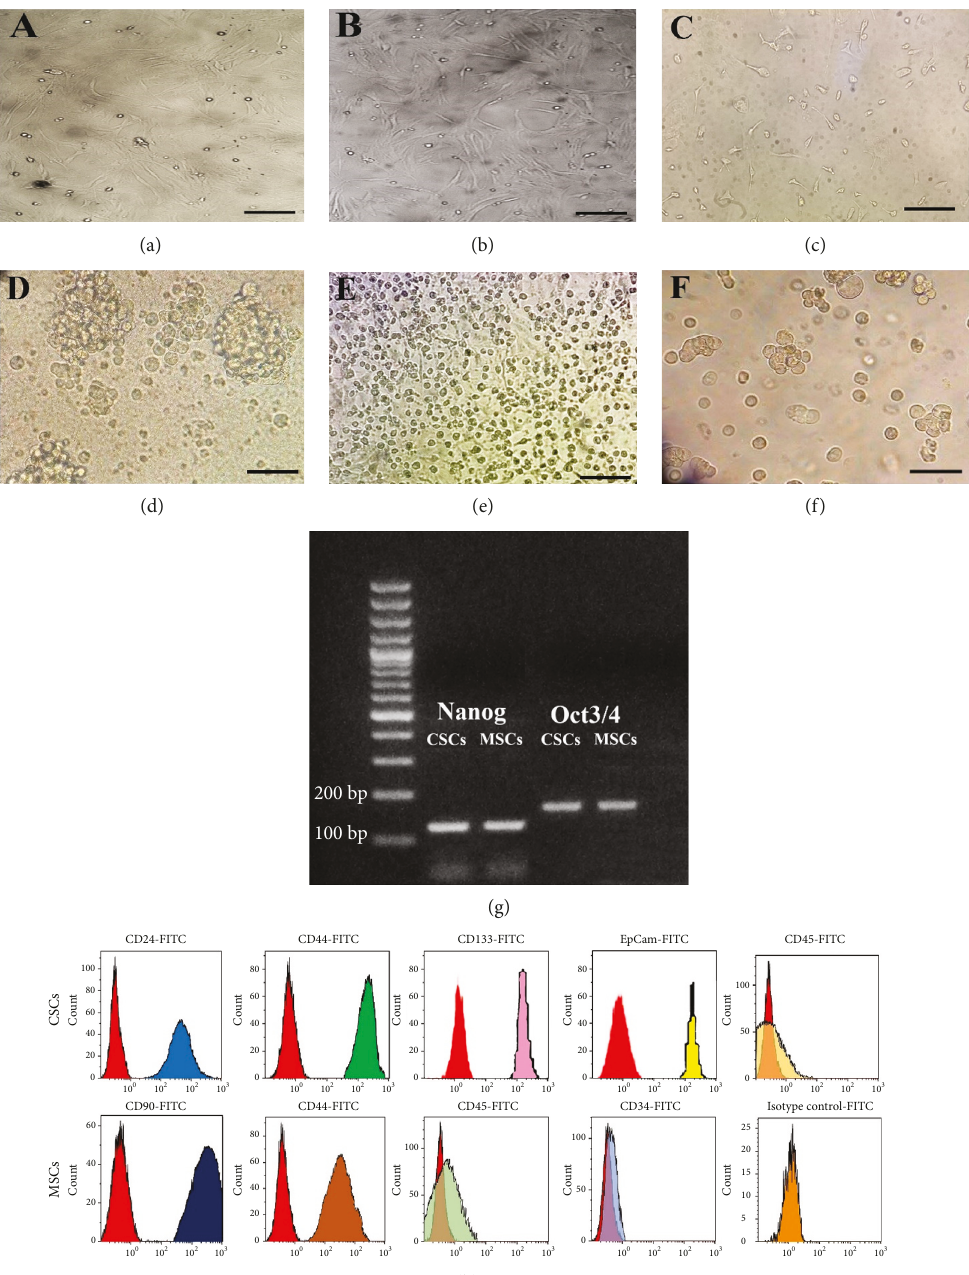
Figure 1: Identi fi cation of cultured CSCs and MSCs. MSCs with their characteristic fusiform ( fi broblast-like) shape were grown after passage 2 (a) and passage 8 (b). After 2 weeks of plating HCC explants, stem-like cancer cells were grown (c), with characteristic clonal expansion (d) and a very notable proliferative ability (e), and later on few fl oating cells forming spheres appeared (f). The isolated CSCs and MSCs con fi rmed by detection of stem cell-speci fi c genes Nanog (120bp) and Oct3/4 (165bp) using RT-PCR (g), and by fl ow cytometry which revealed that CSCs were CD24 + , CD44 + , CD133 + , EpCam + , and CD45 − , while MSCs were CD90 + , CD44 + , CD45 − , and CD34 − (h). Scale bars: 35 μ m (c – e) and 50 μ m (a, b,